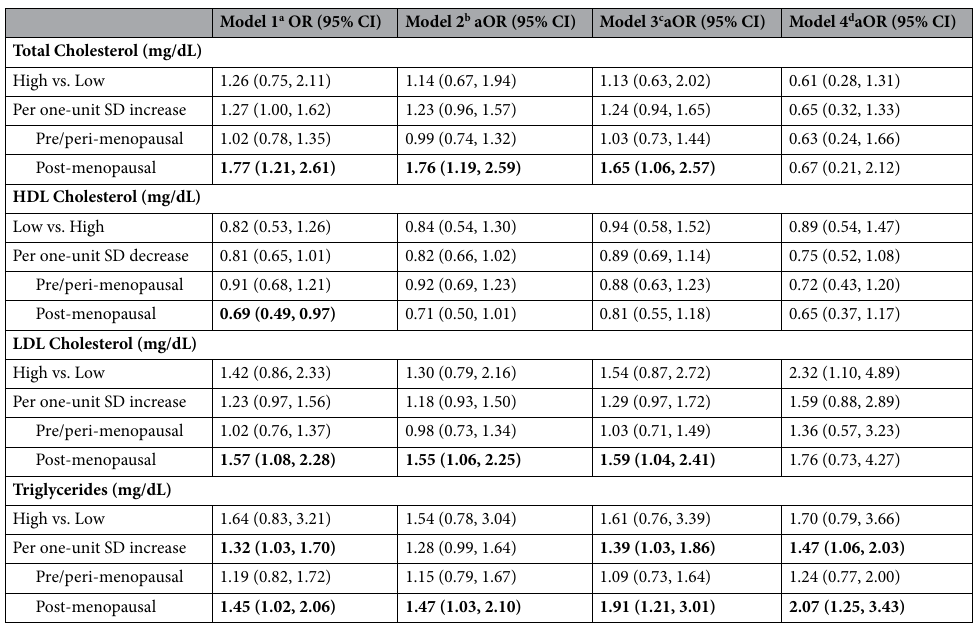
Table 3. Associations between lipid profile biomarkers and odds of cancer status. Logistic regression models for the odds of having cancer by lipid profile biomarkers. ORs per one-unit SD were modeled as a one- unit increase/decrease in SD of the lipid profile variable from its mean-centered value. Bolded values indicate significance at p<.05. High total cholesterol defined as >200 mg/dL; low HDL defined as <50 mg/dL; high LDL defined as >100 mg/dL; high triglycerides defined as >150 mg/dL. a Model 1, unadjusted. b Model 2, adjusted for age. c Model 3, additionally adjusted for clinical characteristics: BMI, age at menarche, number of pregnancies, number of births, hypertension at enrollment, and menopausal status. d Model 4, additionally adjusted for all lipid profile biomarkers: total cholesterol, LDL, HDL, and triglycerides. OR odds ratio, CI confidence interval, aOR adjusted odds ratio, SD standard